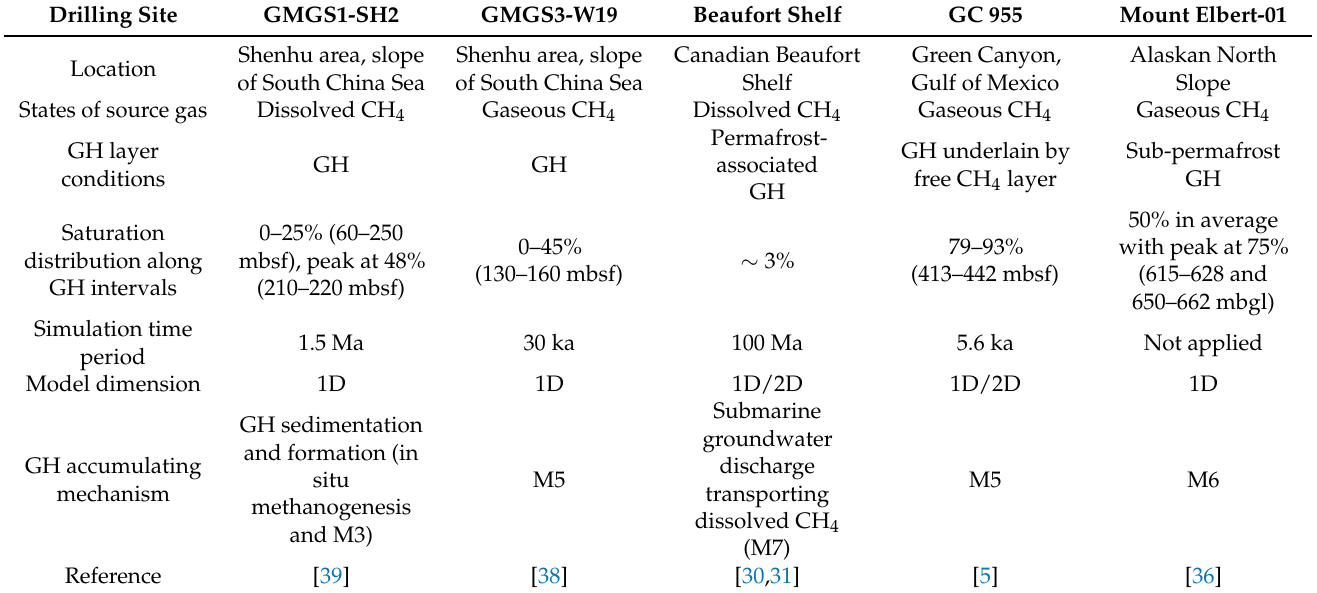
Table 1. Summary of numerical models used to investigate GH accumulation mechanisms and comparisons of deposit features characterizing the evolution pattern of GH